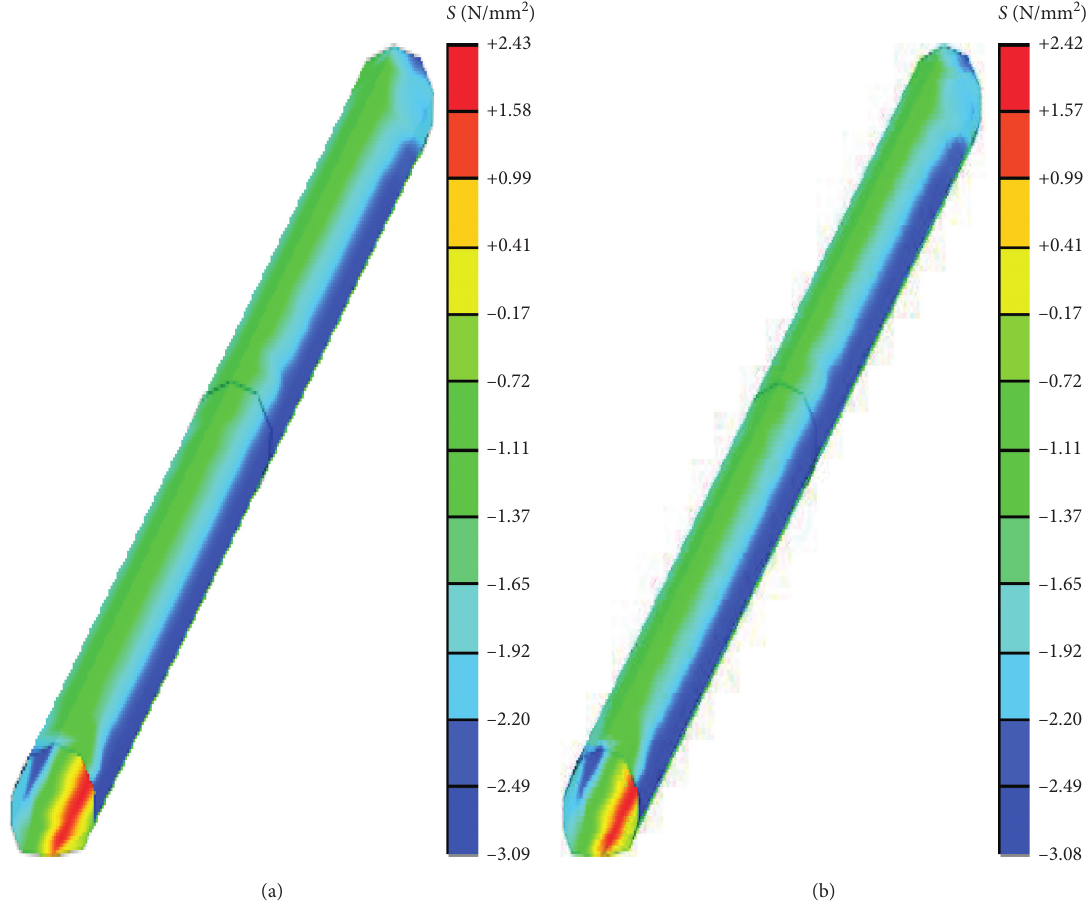
Figure 8: Cloud diagram of maximum principal stress of the existing tunnel lining. (a) Excavation program I. (b) Excavation program